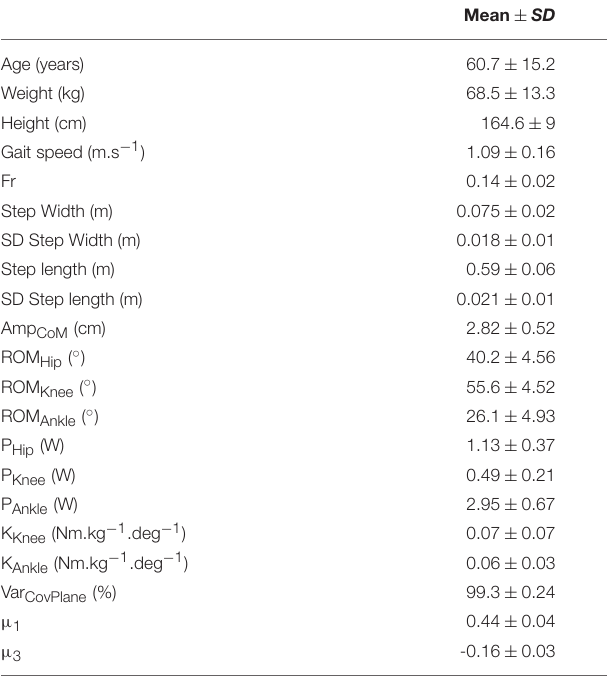
TABLE 1 | Population characteristics.